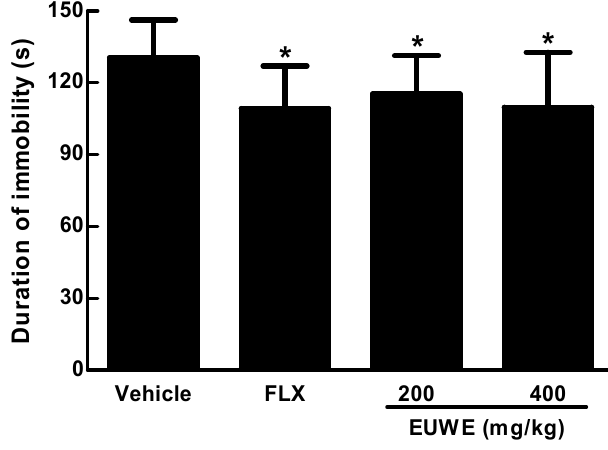
Figure 5. Antidepressant effect of water extract of E. ulmoides of (EUWE) in the tail suspension test of mice in vivo . The mice were treated orally with EUWE at 200 or 400 mg/kg/day, fluoxetine (FLX) at 8 mg/kg/day and distilled water as vehicle control daily for 7 days. The bars indicate the mean ± SD. The number of mice used for each group was 12. * p < 0.05 compared with distilled water (vehicle) group.